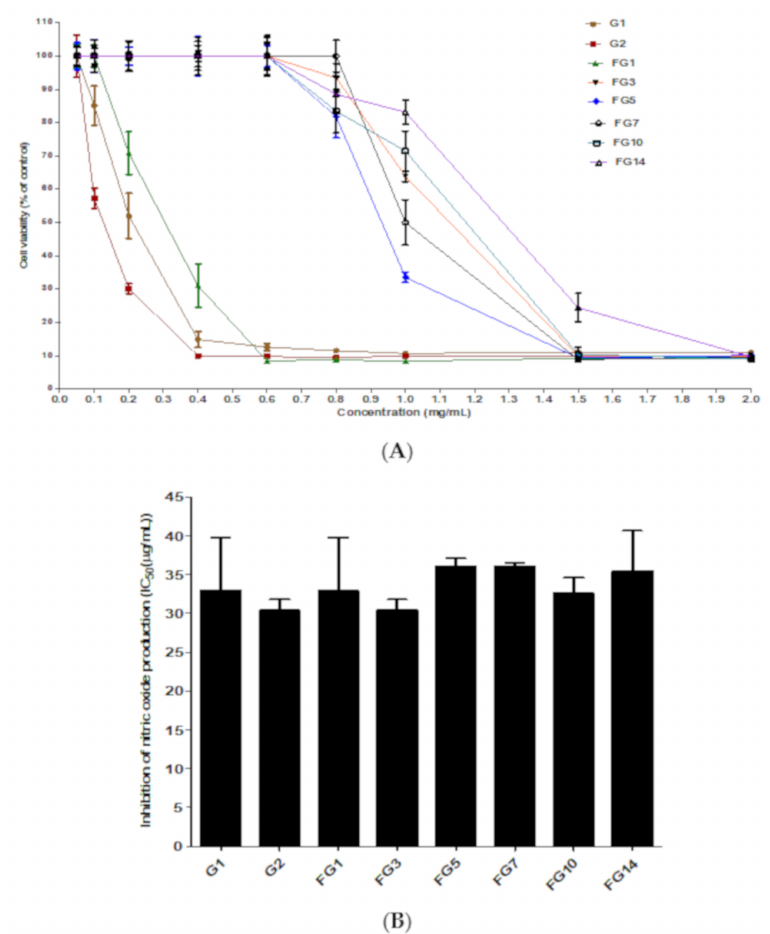
Figure 4. Cell viability ( A ) and nitric oxide inhibition activity ( B ) of fermented wild ginseng by R. oligosporus on RAW264.7 murine macrophage cells. ( A , B ) ( • , G1 ): wild ginseng extract;